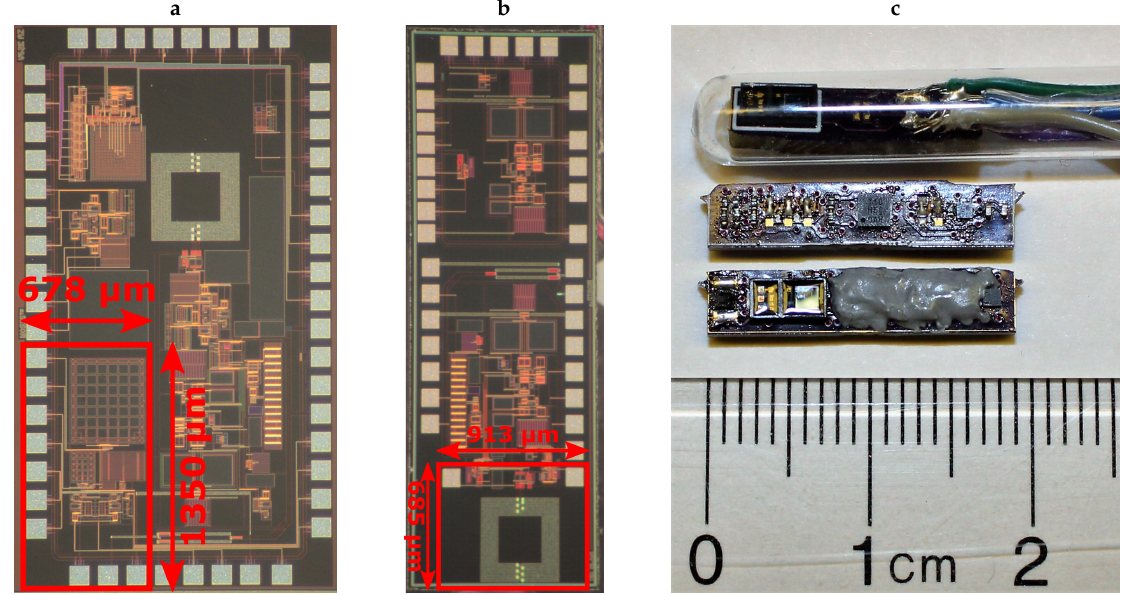
Figure 2. Micrographs of the two ASICs (before being wire bonded to the PCB) and a photo of the overall system. ( a ) The delimited die area measures approximately 1.3 0.7 mm 2 and represents the × transimpedance amplifier, current digital-to-analog converter, and switched integrator. ( b ) The delimited die area measures approximately 0.7 0.9 mm 2 and represents the FSK transmitter. ( c ) Picture of the × injectable optical probe with an OSRAM BioMon sensor in the glass encapsulation (top) and the two sides of the fully assembled injectable PPG